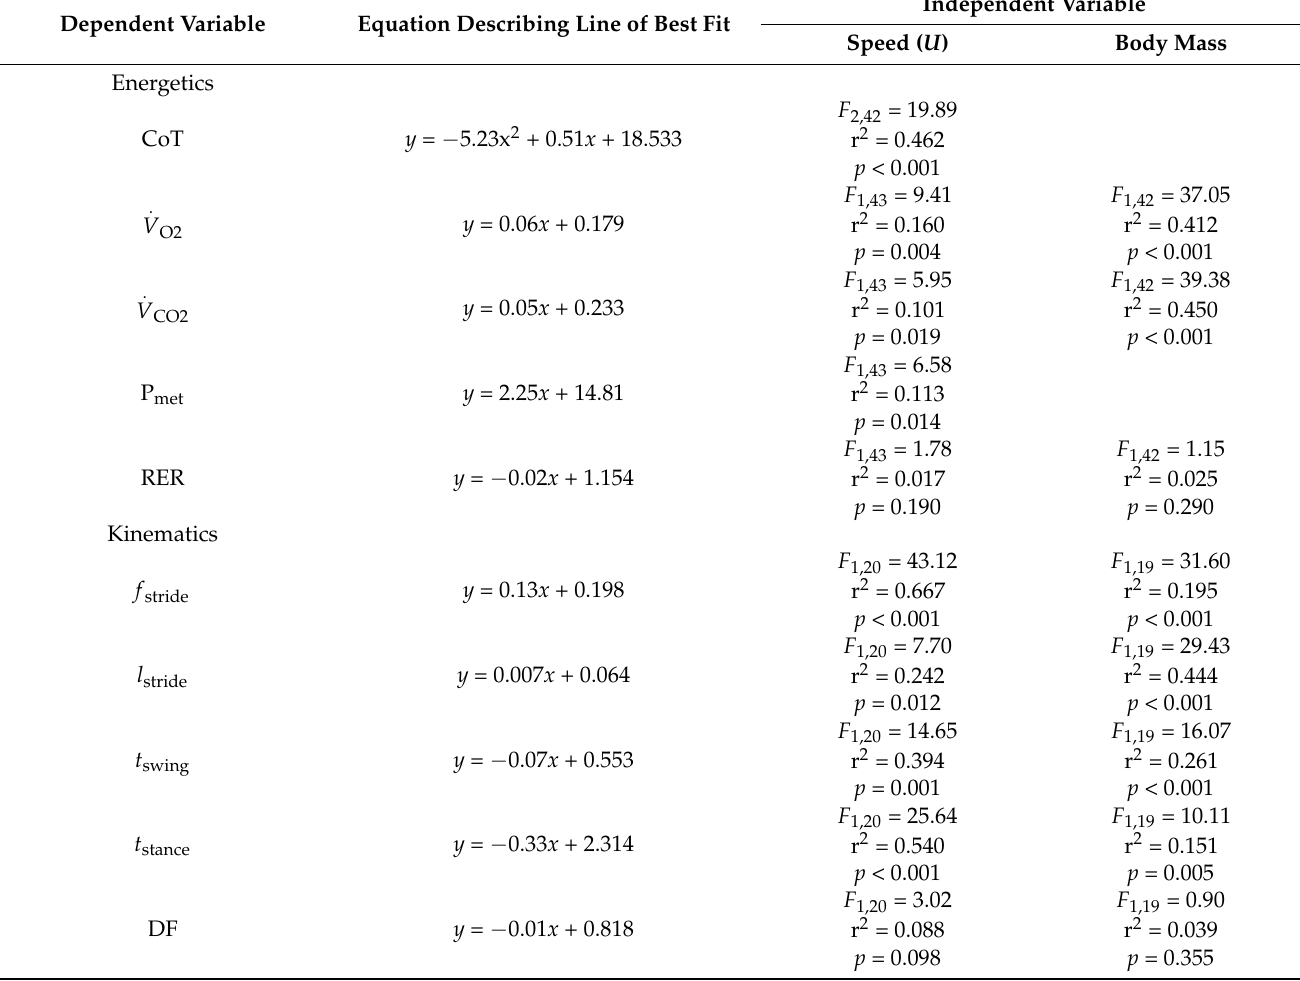
Table 1. The results of statistical tests conducted to determine the effects of speed ( U ) and mass on the energetic and kinematic variables. No interactions between mass and U were found for any of the dependent variables, so the statistical models were reduced to main effect terms